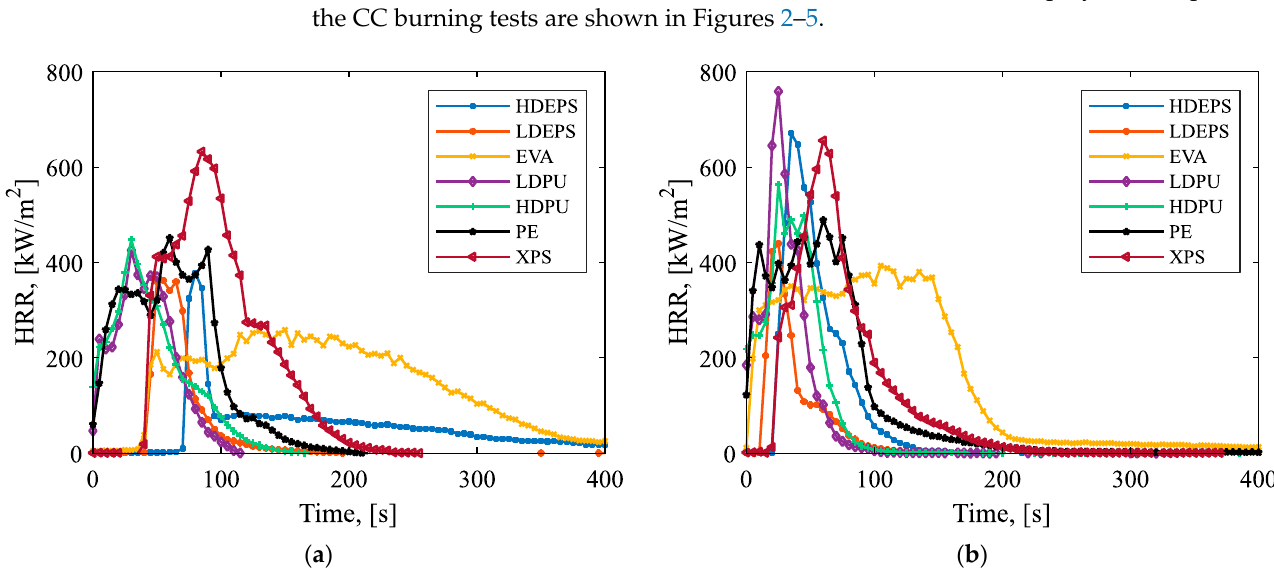
Figure 2. HRR time profile of polymer samples at ( a ) 35 kW/m 2 ; ( b ) 50 kW/m 2 heat fluxes.